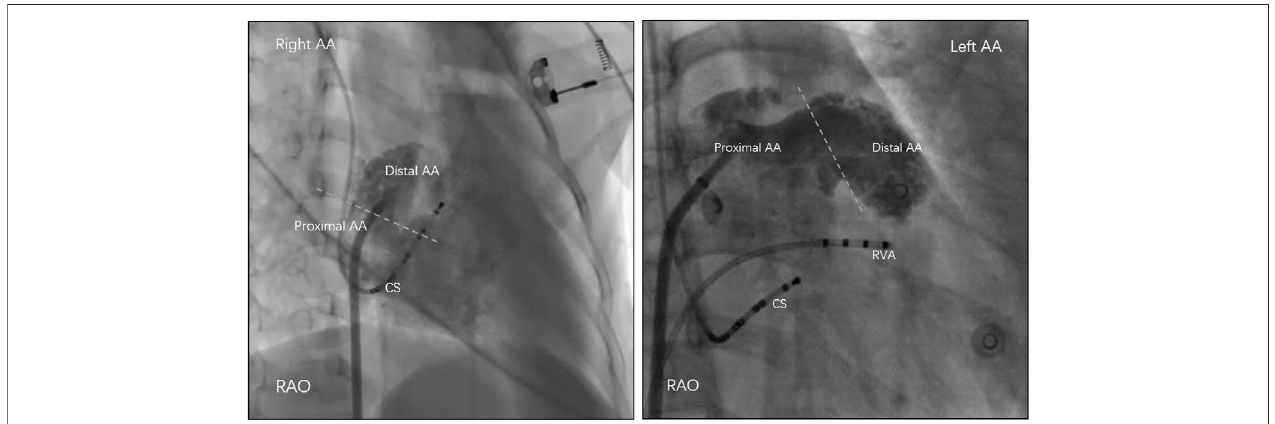
FIGURE 1 | The atrial appendage (AA) was arbitrarily divided into two sections by contrast venography: proximal AA and distal AA. In detail, the proximal portion hadasmoothendocardialcontour,whilethedistalportionthatwashighlytrabeculatedhadanunevencontour.RAO=rightanterioroblique;CS=coronarysinus;RVA= right ventricular apex.